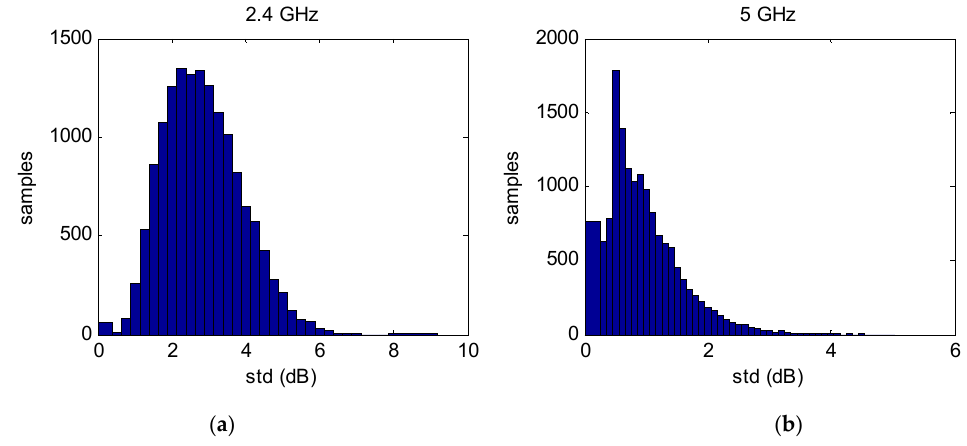
Figure 10. Deviation of the RSS within the subsets ( a ) 2.4 GHz Wi-Fi data; ( b ) 5 GHz Wi-Fi data.